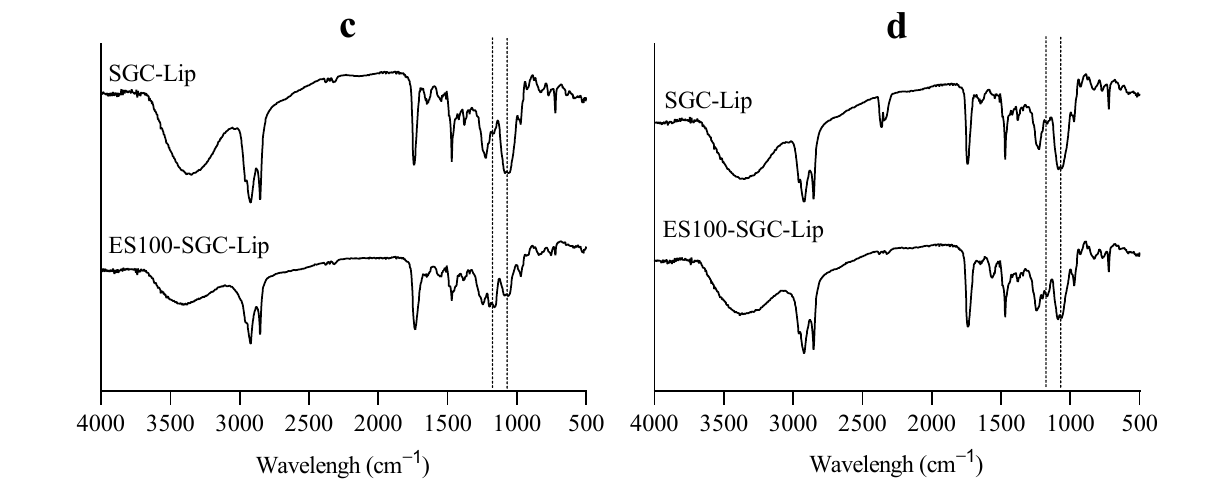
Figure 7. FTIR spectra of SGC-Lip and ES100-SGC-Lip obtained after 2-h incubation at 37 °C in ( a ) SGC pH 1.2, ( b ) FaSSIF pH 6.5, ( c ) FeSSIF pH 5, ( d ) PBS pH 7.4.